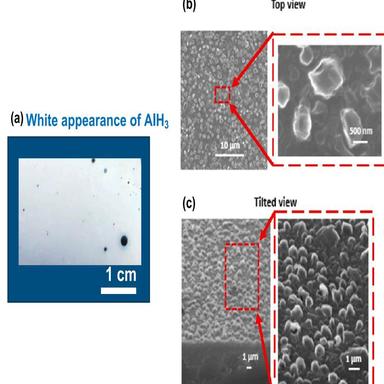
AlH3 thin film surface characterization: (a) The physical appearance of the AlH3 thin film shows a distinct white coloration; (b) the SEM top view image displays the surface morphology of the film, revealing details of its texture; and (c) the SEM image acquired at a tilted angle offers an insight into the surface roughness and topographical variations of the thin film. This angle allows for a better understanding of its thickness and surface irregularities.